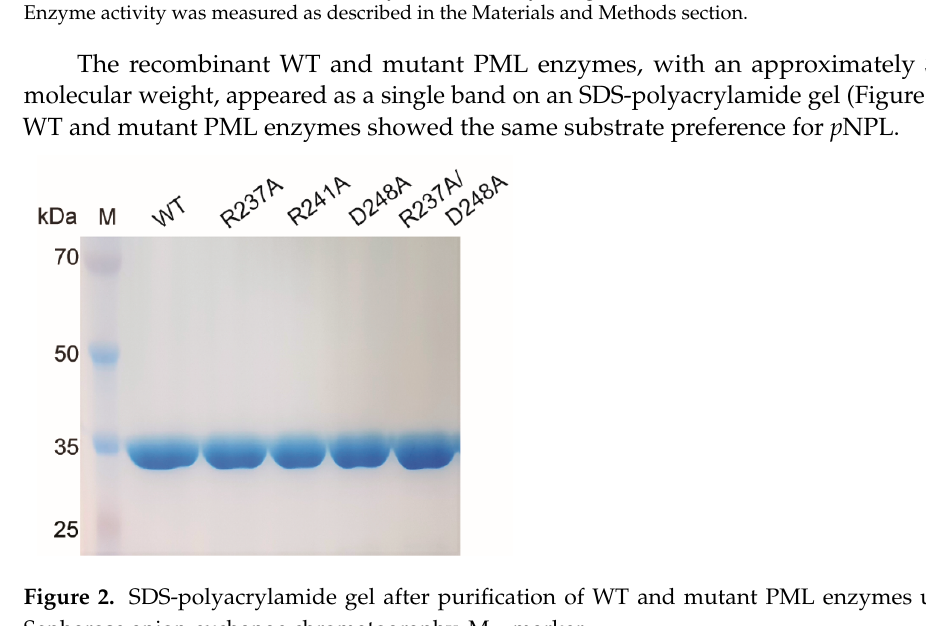
Table 1. Purification summary of the WT and mutant PML enzymes.